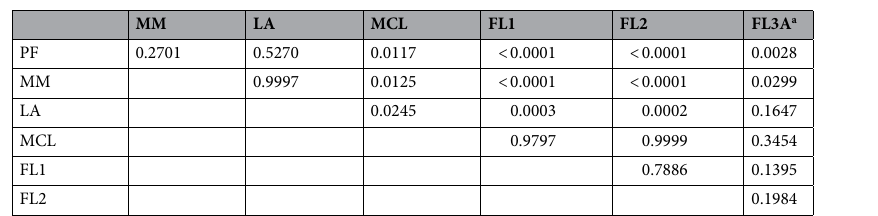
Table 3. p -value in comparisons of abnormal type 53BP1 expression among small cell lymphoid lesions. PF primary follicle, MM mantle-marginal zone, LA simple lymphoid accumulation, MCL mantle cell lymphoma, FL 1, 2, 3A follicular lymphoma grade 1, 2, 3A. a These cases mainly consisted of small cells but large cells (centroblasts and immunoblasts) less than